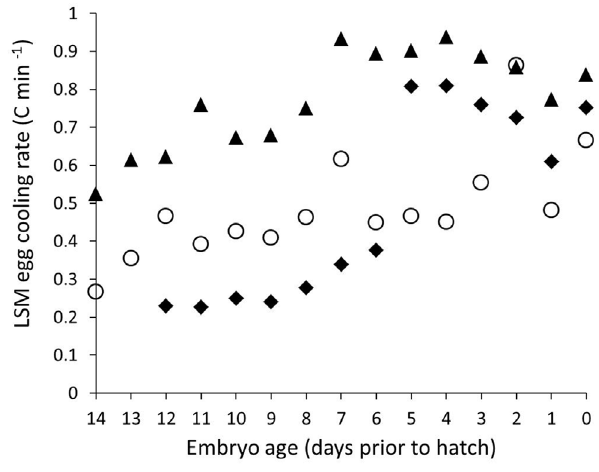
Figure 1. Egg-cooling rates during incubation off-bouts. Least squares mean estimates ( 6 SE) of egg-cooling rates ( u C min 2 1 ) increased as embryos aged for naturally incubated eggs in 21 black- capped chickadee nests for clutches of size 3 (diamonds), 6 (triangles), and 8 (circles).